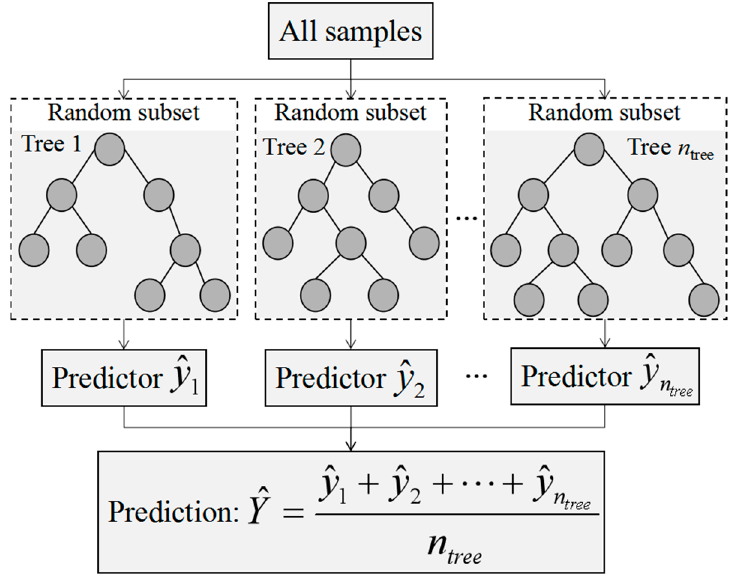
Figure 2. The main structure of random forest algorithm.